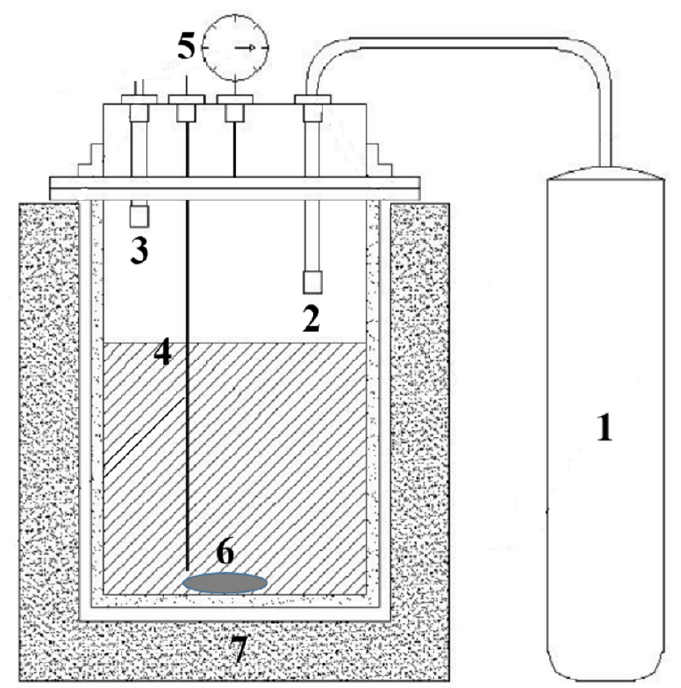
Figure 1. Schematic diagram of carbonation reactor, 1—CO 2 cylinder; 2—Air inlet; 3—Air outlet; 4—Thermometer; 5—Barometer; 6—Magnetic rotor; 7—Heating equipment. 𝑚 was determined by thermogravimetric analysis (TG-DTG), using Setsys Evo (cid:3004)(cid:3016) (cid:3118) ) carbonate EAF slag under N 2 type thermogravimetric analyzer to collect 30 mg ( 𝑚 (cid:3046)(cid:3039)(cid:3028)(cid:3034) atmosphere at a rate of about 0.33 °C/s at room temperature to 900 °C in the process of the characteristics of gravity (TG) curves. The weight loss temperature range of CaCO 3 in the